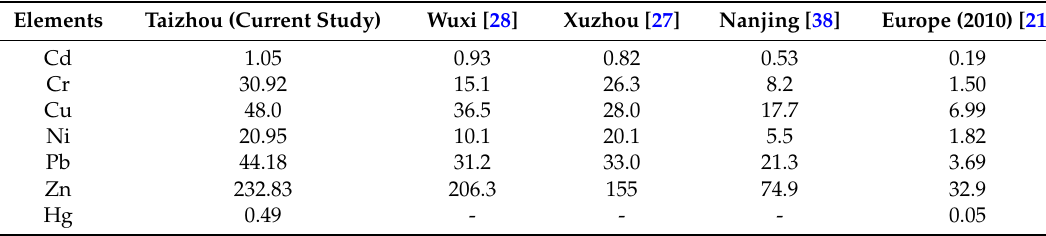
Table 3. Comparison of the mean concentrations of heavy metals from mosses in Taizhou, neighboring cities in China, and Europe (mg · kg − 1